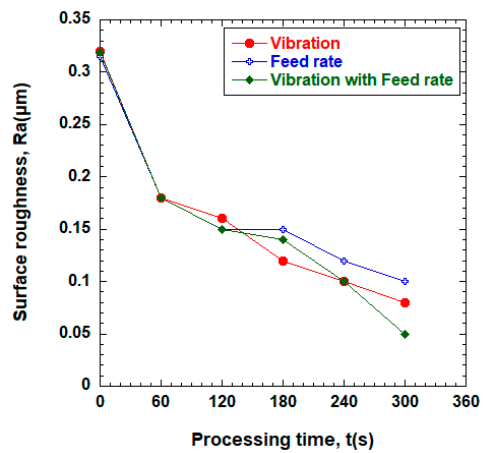
Figure 12. Surface roughness (Ra) vs. finishing time for multi-feed movement (vibration: 8 Hz; abrasive: